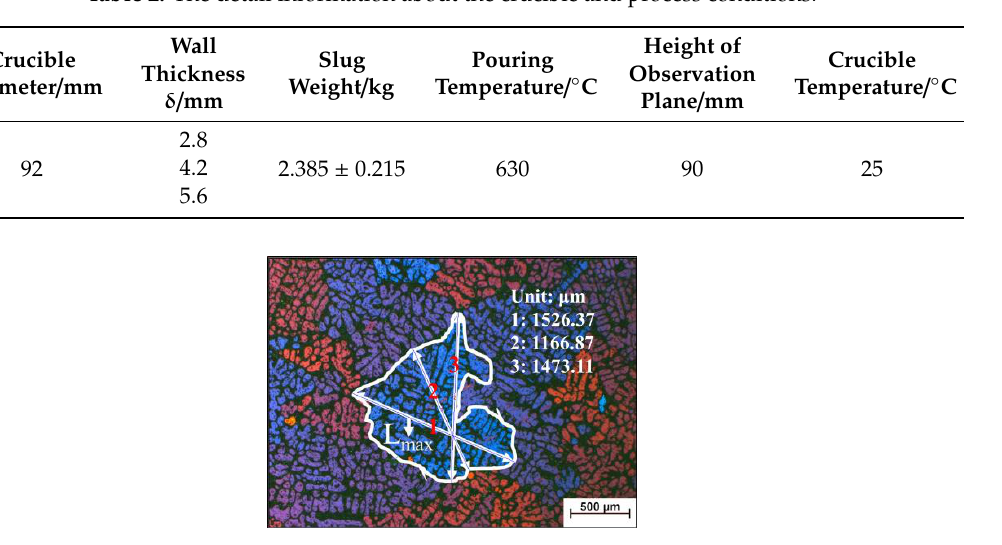
Figure 4. Schematic for the definition of grain size d, d = L max .